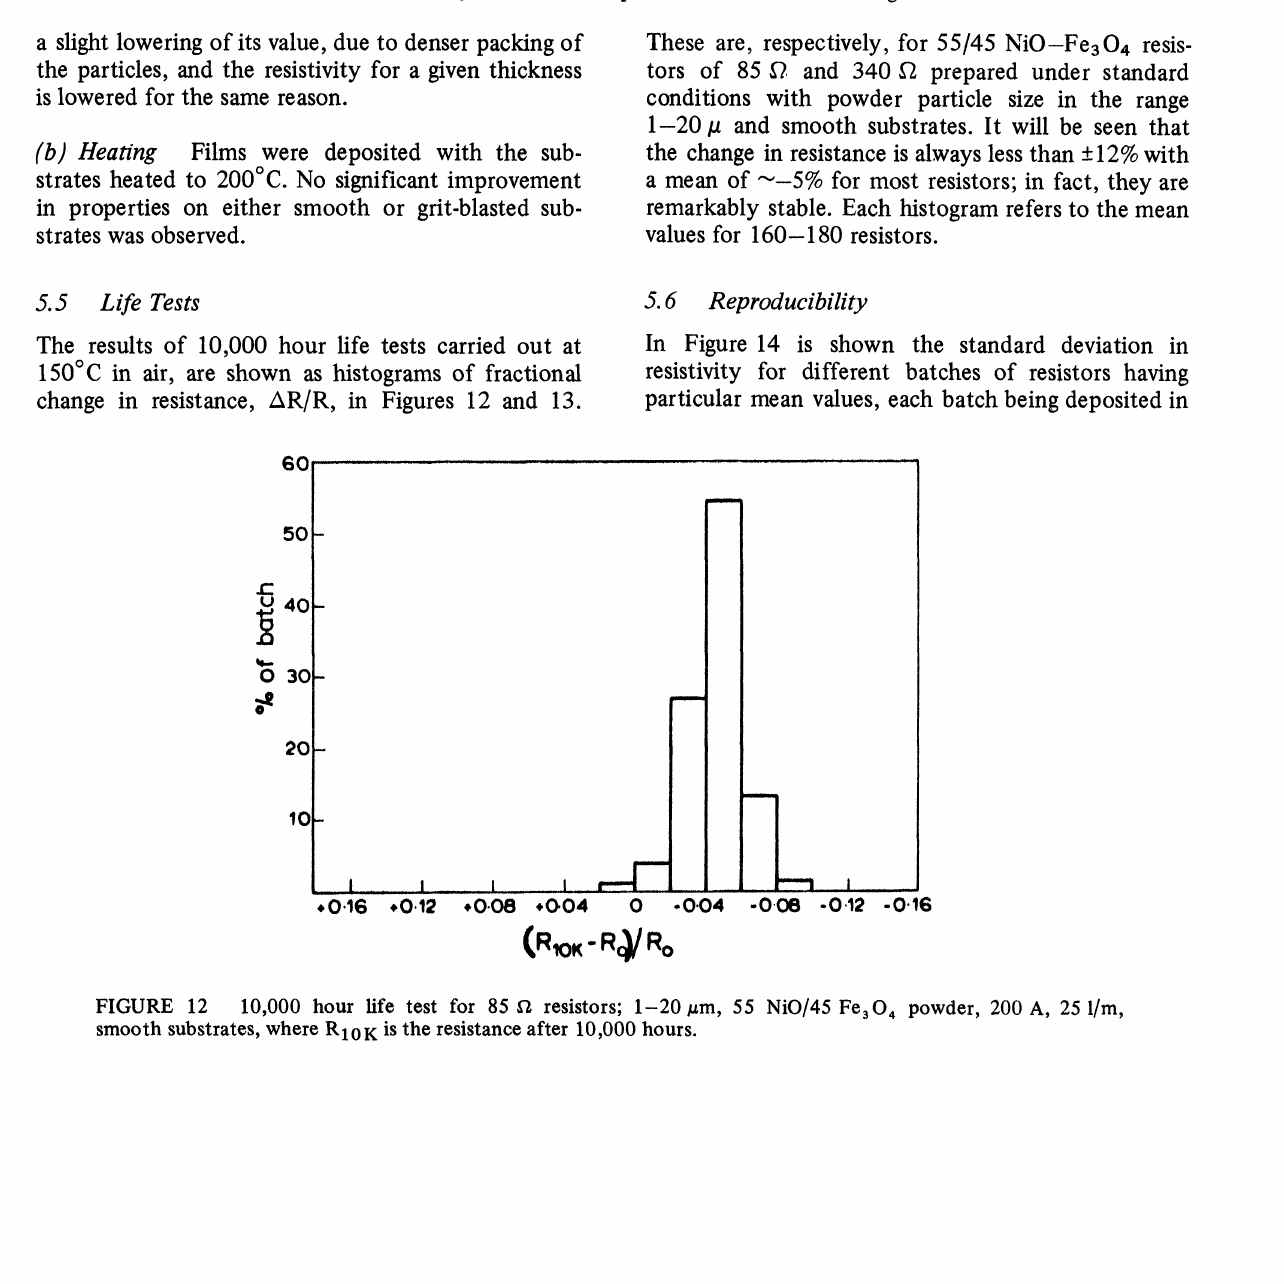
FIGURE 11 Resistivity as a function of particle size for the films of Figure 10.